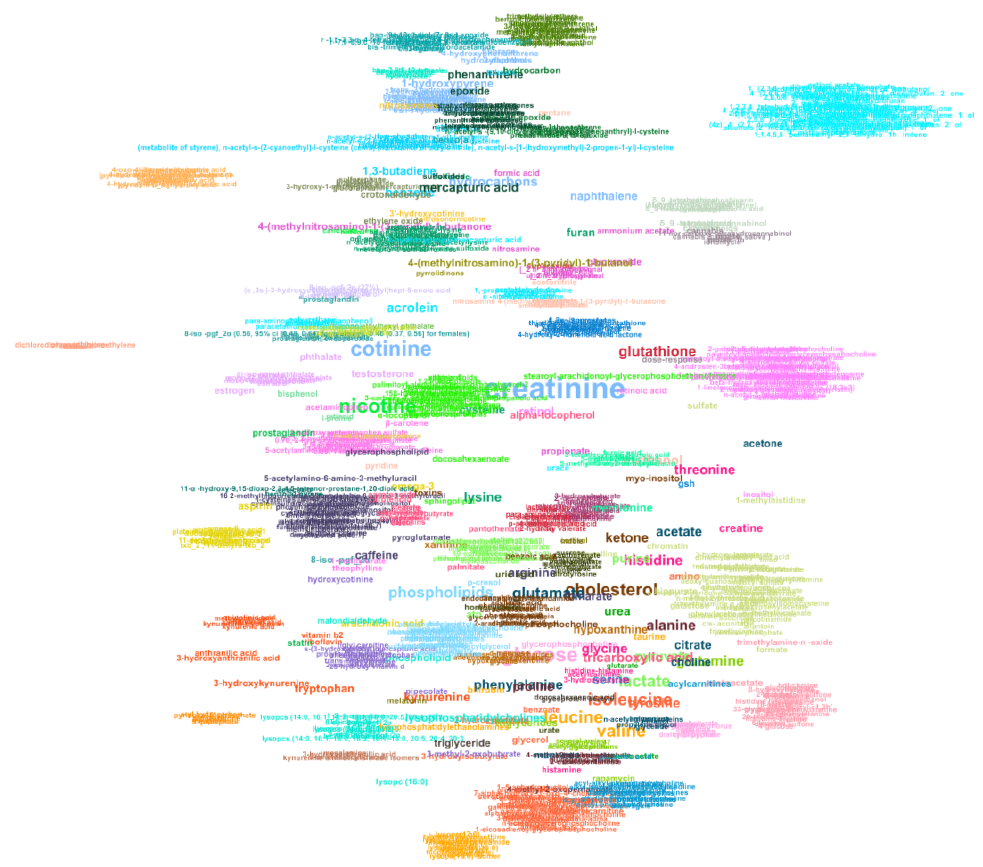
Figure A2. Graphical representation of metabolites mentioned in 124 smoking-related metabolomics articles. Each node represents a metabolite and the closer metabolites appear in the graph, the more likely they are to appear together in articles. The displayed metabolite names are sized proportionally to the number of articles that report the metabolite, and are coloured based on the article that reports the metabolite most.